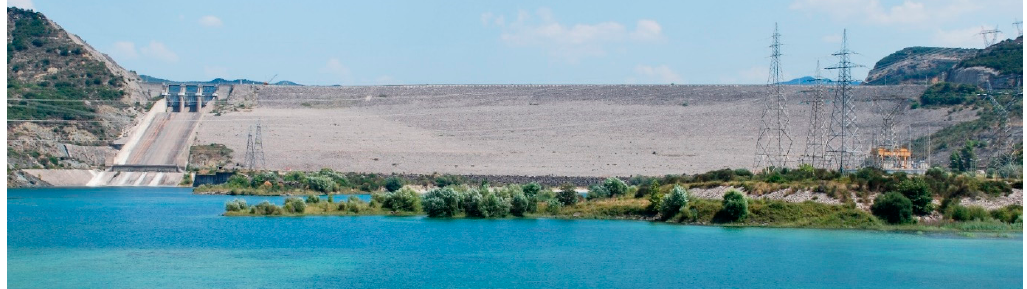
Figure 1. Downstream shoulder of the Pournari I dam with the concrete spillway (left) and part of the hydroelectric station (right).